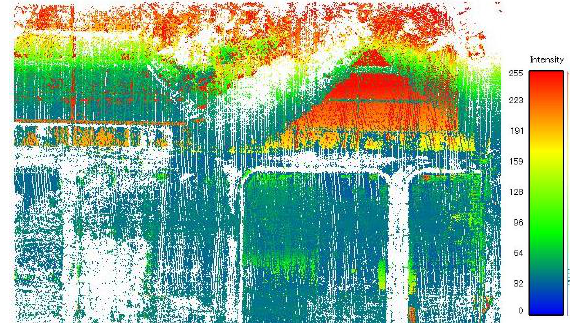
Figure 12. Reflection intensity image of channel 8